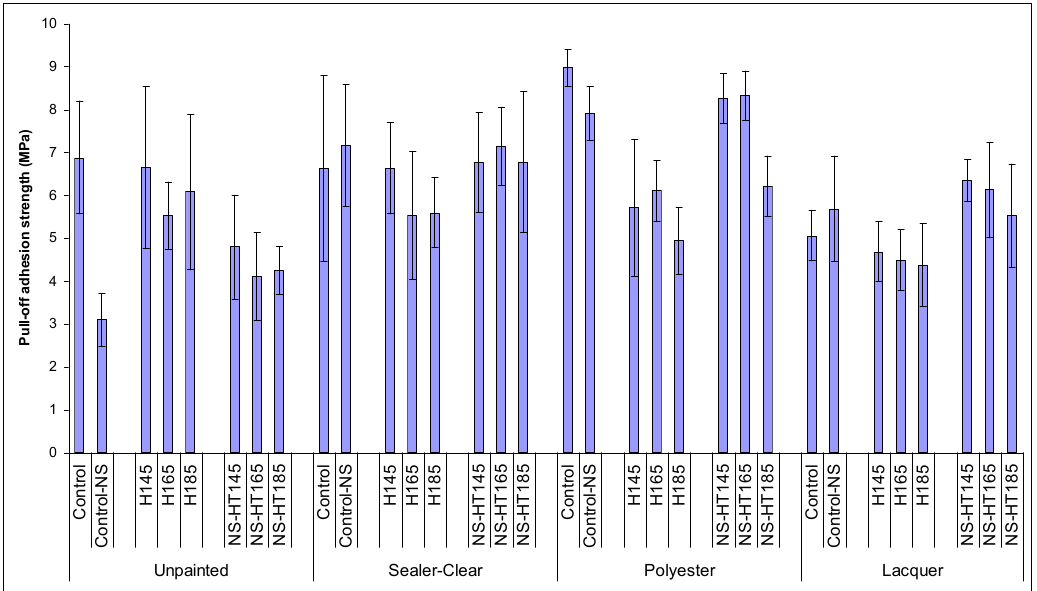
Figure 3. Pull-o ff adhesion strength (MPa) of di ff erent treatments of beech specimens (error bars Figure 3. Pull-off adhesion strength (MPa) of different treatments of beech specimens (error bars indicate the standard deviation for each indicate the standard deviation for each column).